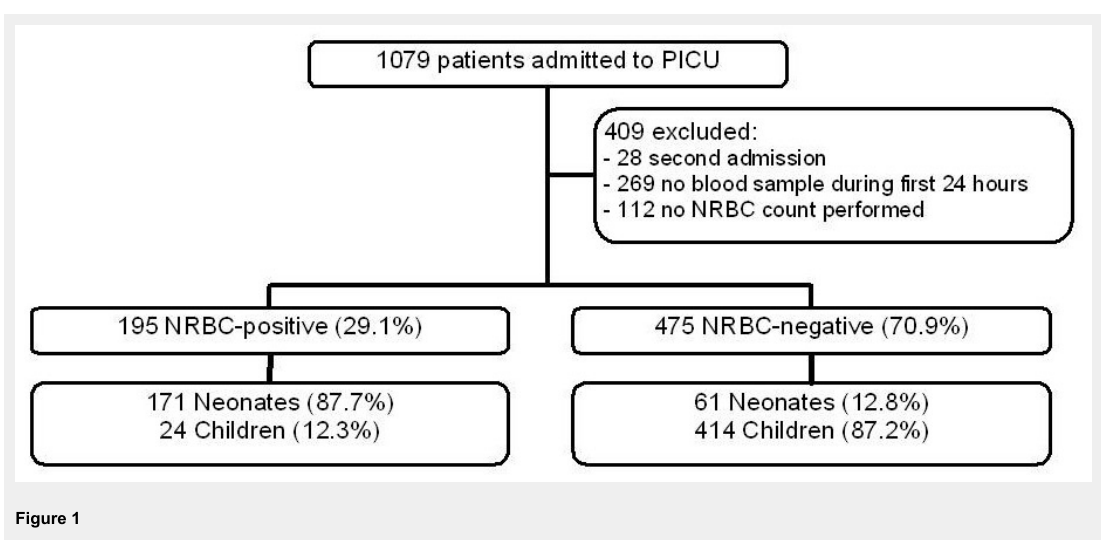
Figure 1 Inclusion and exclusion criteria. NRBC = nucleated red blood cell; PICU = paediatric intensive care